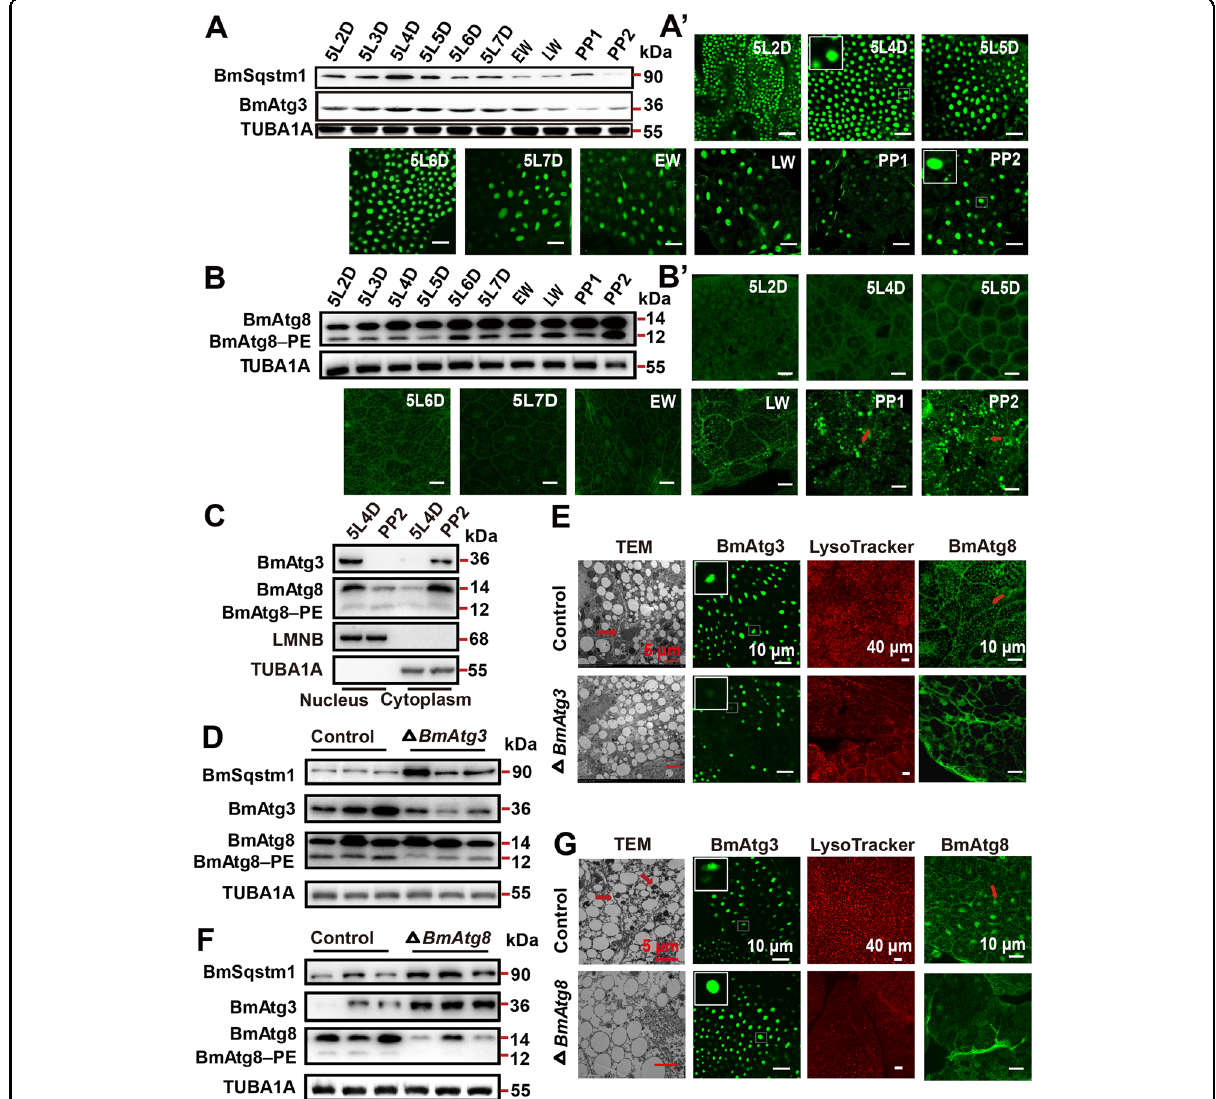
Fig. 1 BmAtg8 and BmAtg3 are essential for autophagy induction in B. mori fat body. A – A ′ Protein levels of BmSqstm1 and BmAtg3 ( A ), immuno fl uorescent staining of BmAtg3 (A ′ ) in B. mori fat body from 5L2D to PP2 stage. EW early wandering stage, LW later wandering stage. Scale bar: 10 µm. B – B ′ Protein levels ( B ) and immuno fl uorescent staining (B ′ ) of BmAtg8 in B. mori fat body from 5L2D to PP2 stage. Arrows: typical fat body cell. Scale bar: 10 µm. C Protein levels of BmAtg3 and BmAtg8 in the nucleus and cytoplasm at 5L4D and PP2 stages. D Protein levels of BmSqstm1, BmAtg3, and BmAtg8 after BmAtg3 knockout. E LysoTracker Red staining, TEM analysis, and immuno fl uorescent staining of BmAtg3 and BmAtg8 after BmAtg3 knockout. F Protein levels of BmSqstm1, BmAtg3, and BmAtg8 after BmAtg8 knockout. G LysoTracker Red staining, TEM analysis, and immuno fl uorescent staining of BmAtg3 and BmAtg8 after BmAtg8